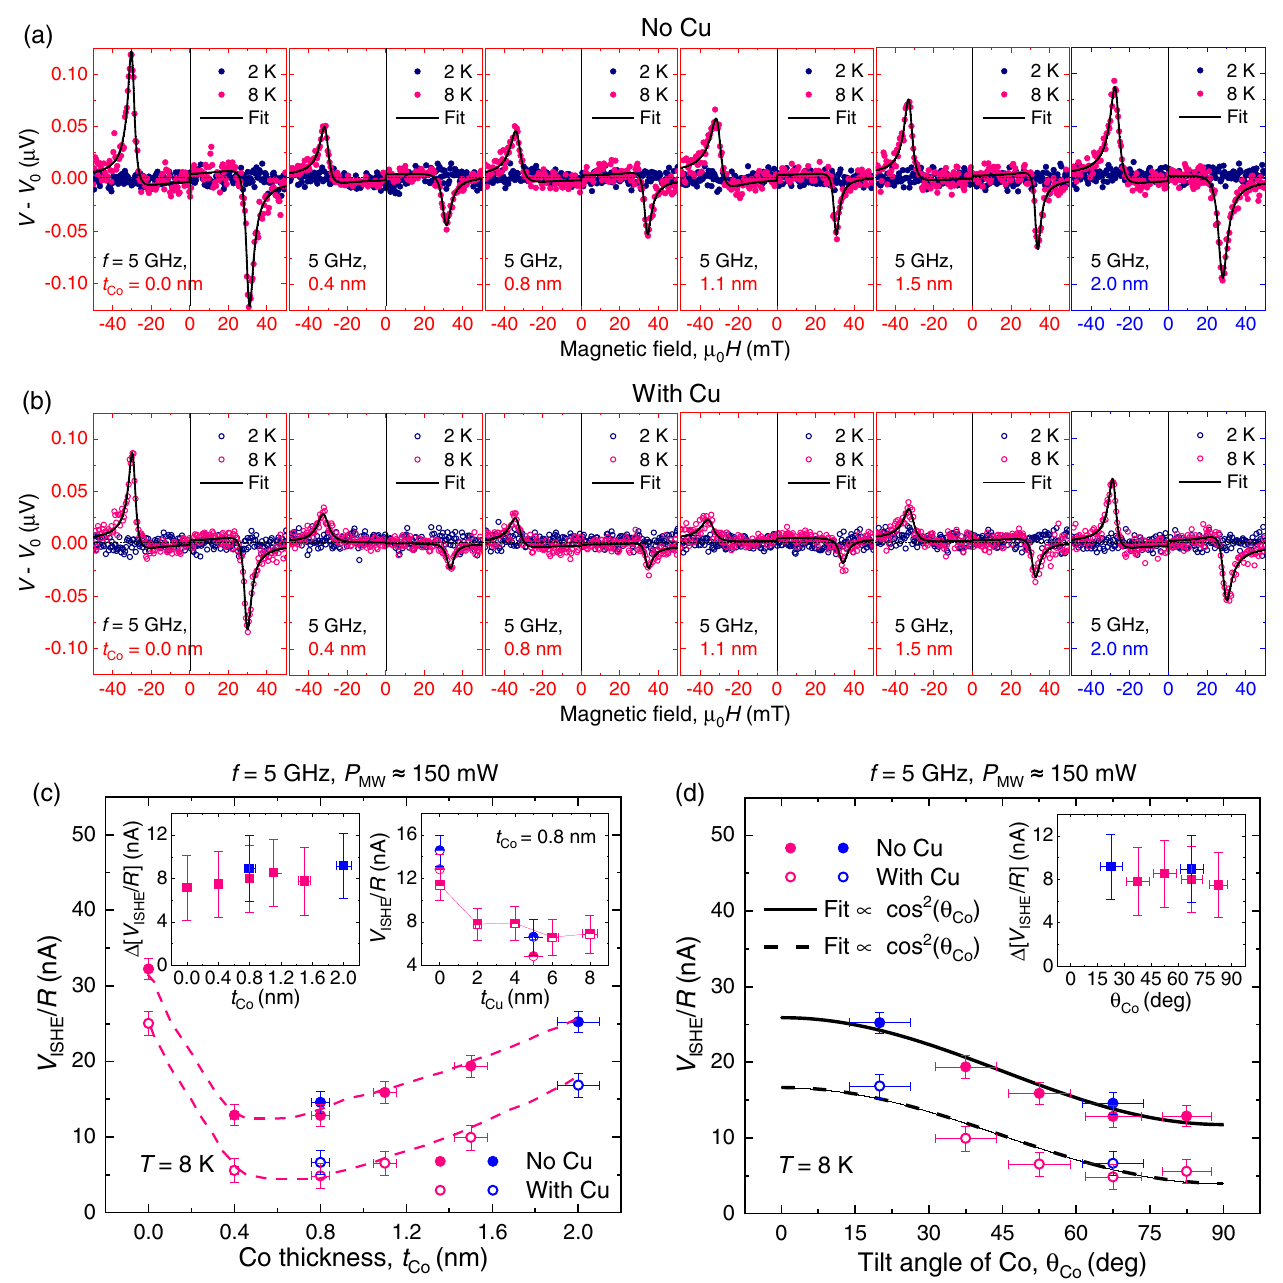
FIG. 3. Effect of Cu spacer addition and Co tilt angle on normal spin-transport properties. (a) Transverse dc voltage measurements for = Pt ð 1 . 7 nm Þ = Nb ð 30 nm Þ = Ni 8 Fe 2 ð 6 nm Þ samples with various Co thicknesses t at a fixed microwave asymmetric Pt ð 2 . 0 nm Þ = Co ð t Co Þ Co of the couple Nb. The black solid lines are fits to Lorentzian functions (see the frequency f ¼ 5 GHz, taken above and below T c = Pt ð 1 . 7 nm Þ = Cu ð 5 nm Þ = Nb ð 30 nm Þ = Ni 8 Fe 2 ð 6 nm Þ Appendix). (b) Data equivalent to (a) but for asymmetric Pt ð 2 . 0 nm Þ = Co ð t Co Þ =R as a function of t (c) and the (effective) samples. Inverse spin Hall effect (ISHE) voltage divided by the sample ’ s resistance V ISHE Co (d) at f ¼ 5 GHz. The dashed lines are guide to the eyes. The left (right) inset in (c) [(d)] shows the signal difference Co tilt angle θ Co dependence of ISHE for the caused by the Cu (5 nm) spacer addition whereas the right inset in (c) exhibits the Cu spacer thickness t Cu 0 . 8 nm samples (see Supplemental Material, Sec. V, for details [17]). The dashed lines in (c) are guide to the eyes, whereas the t Co ¼ for the Cu-absent (Cu-present) samples. The red and blue symbols in (c) and black solid (dashed) line in (d) is a fit to cos 2 ð θ Co Þ (d) represent independent sets of the samples grown each in a single deposition